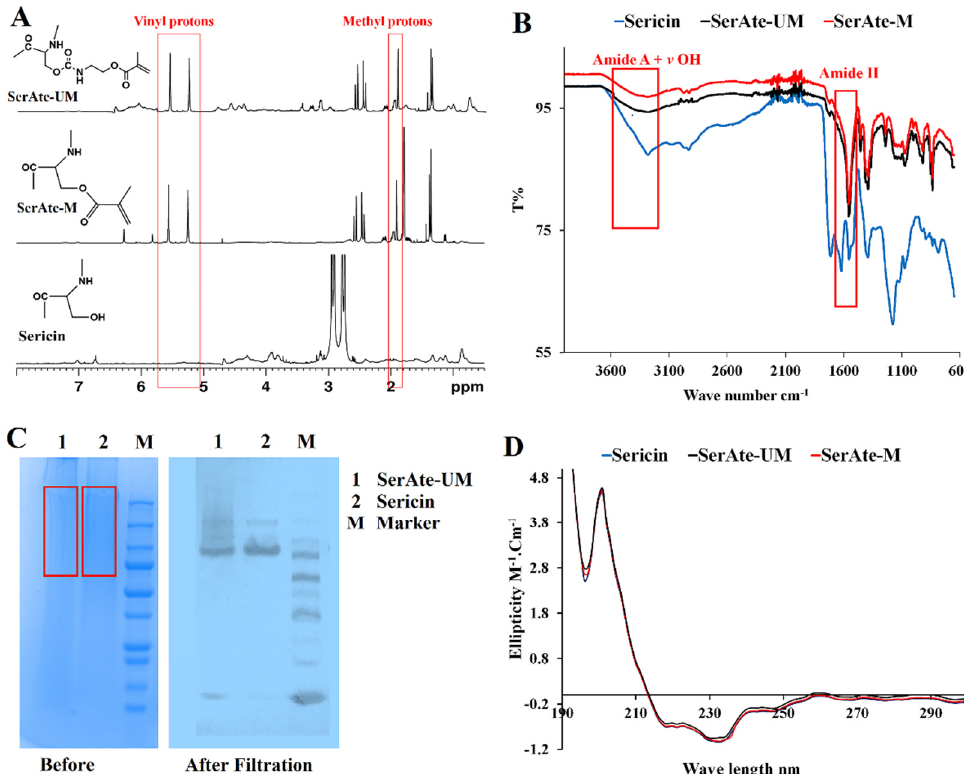
Figure 2. 1 H-NMR ( A ), IR ( B ), and CD ( D ) spectra of sericin (blue), SerAte-M (red), and SerAte-UM (black) in the wavenumber range of 4000–600 cm − 1 ; SDS-PAGE ( C ) of SerAte-UM (1), sericin (2), and the standard protein MW markers (M) before and after filtration. The value of each standard MW for protein markers is provided in ( C ).